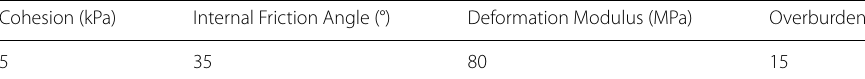
Table 1 Geotechnical parameters used for the analyses Cohesion